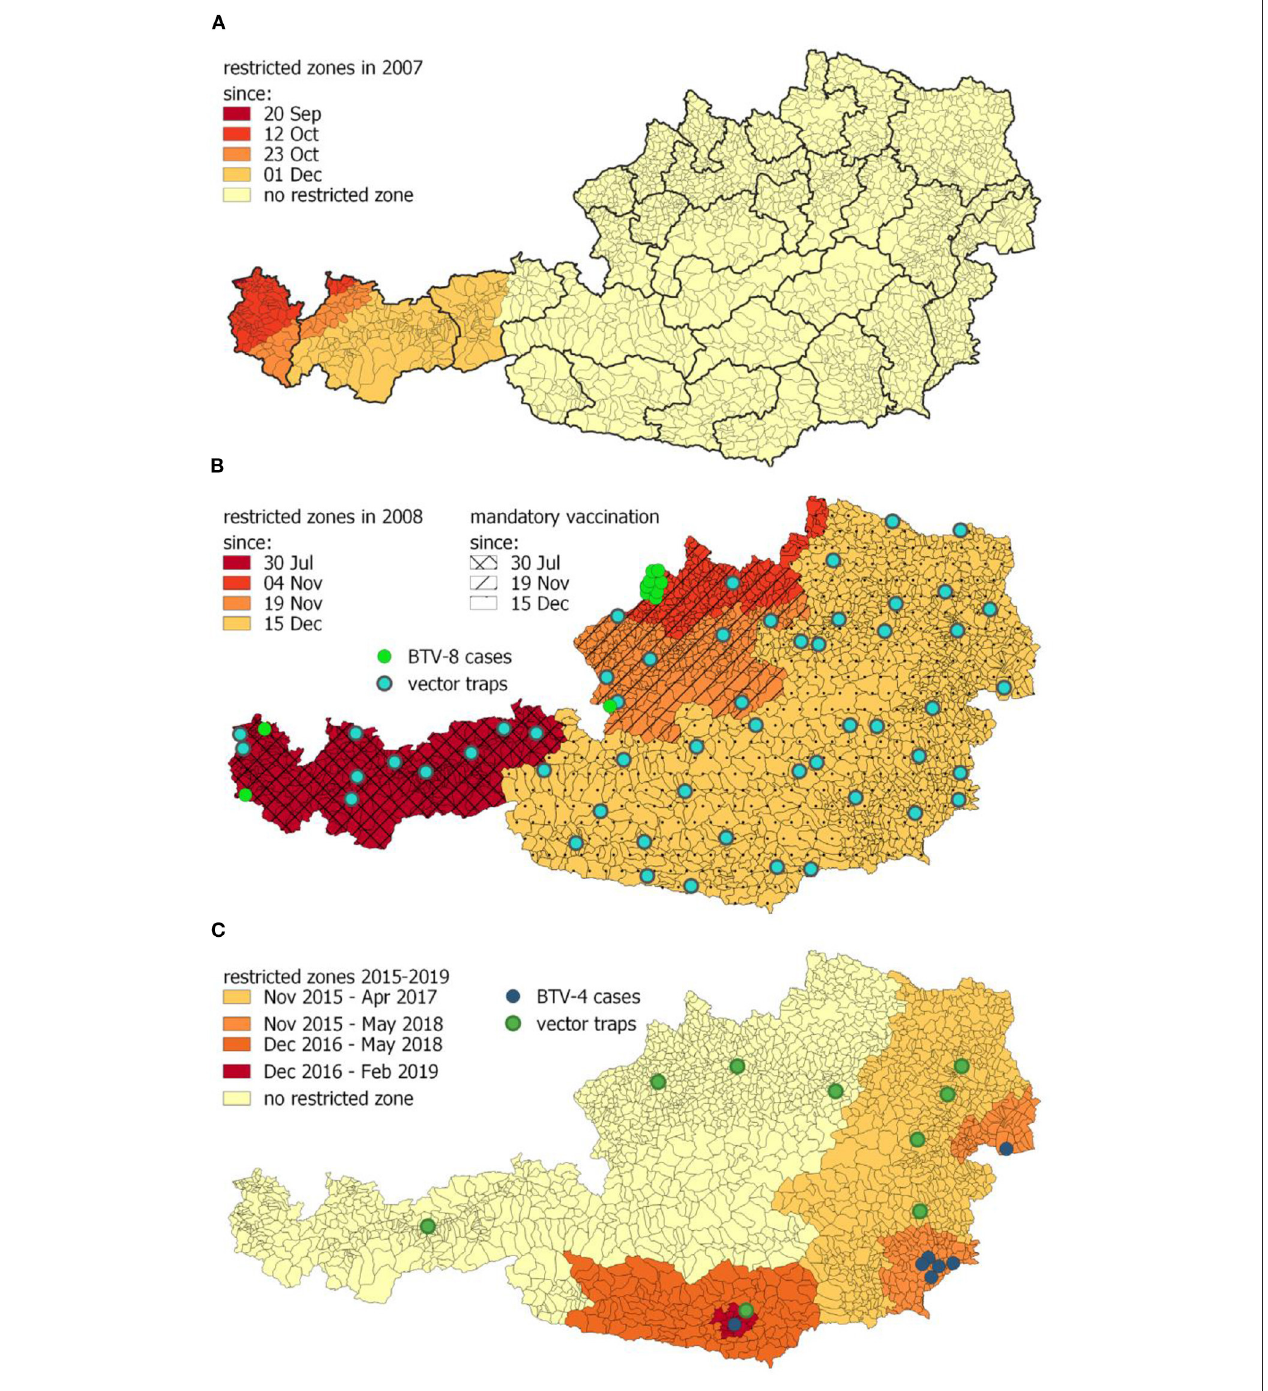
FIGURE 7 | (A) In total, 28 sentinel regions in Austria and the stepwise established restricted zones in 2007 during the BTV-8 outbreak in southern Germany. (B) Distribution of the restricted zones and mandatory vaccination (hatched areas) areas, as a consequence of the BTV-8 cases in western and northwestern Austria (green dots). The restricted zones were repealed in March 2011. Locations of the 54 vector traps to analyze the distribution of Culicoides spp. (blue dots) in Austria. (C) Development of restricted zones from 2015 to 2019, as a consequence of the BTV-4 outbreaks in 2015 and 2016 (blue dots). Green dots represent the vector traps aiming to obtain information to estimate the seasonally vector-free periods